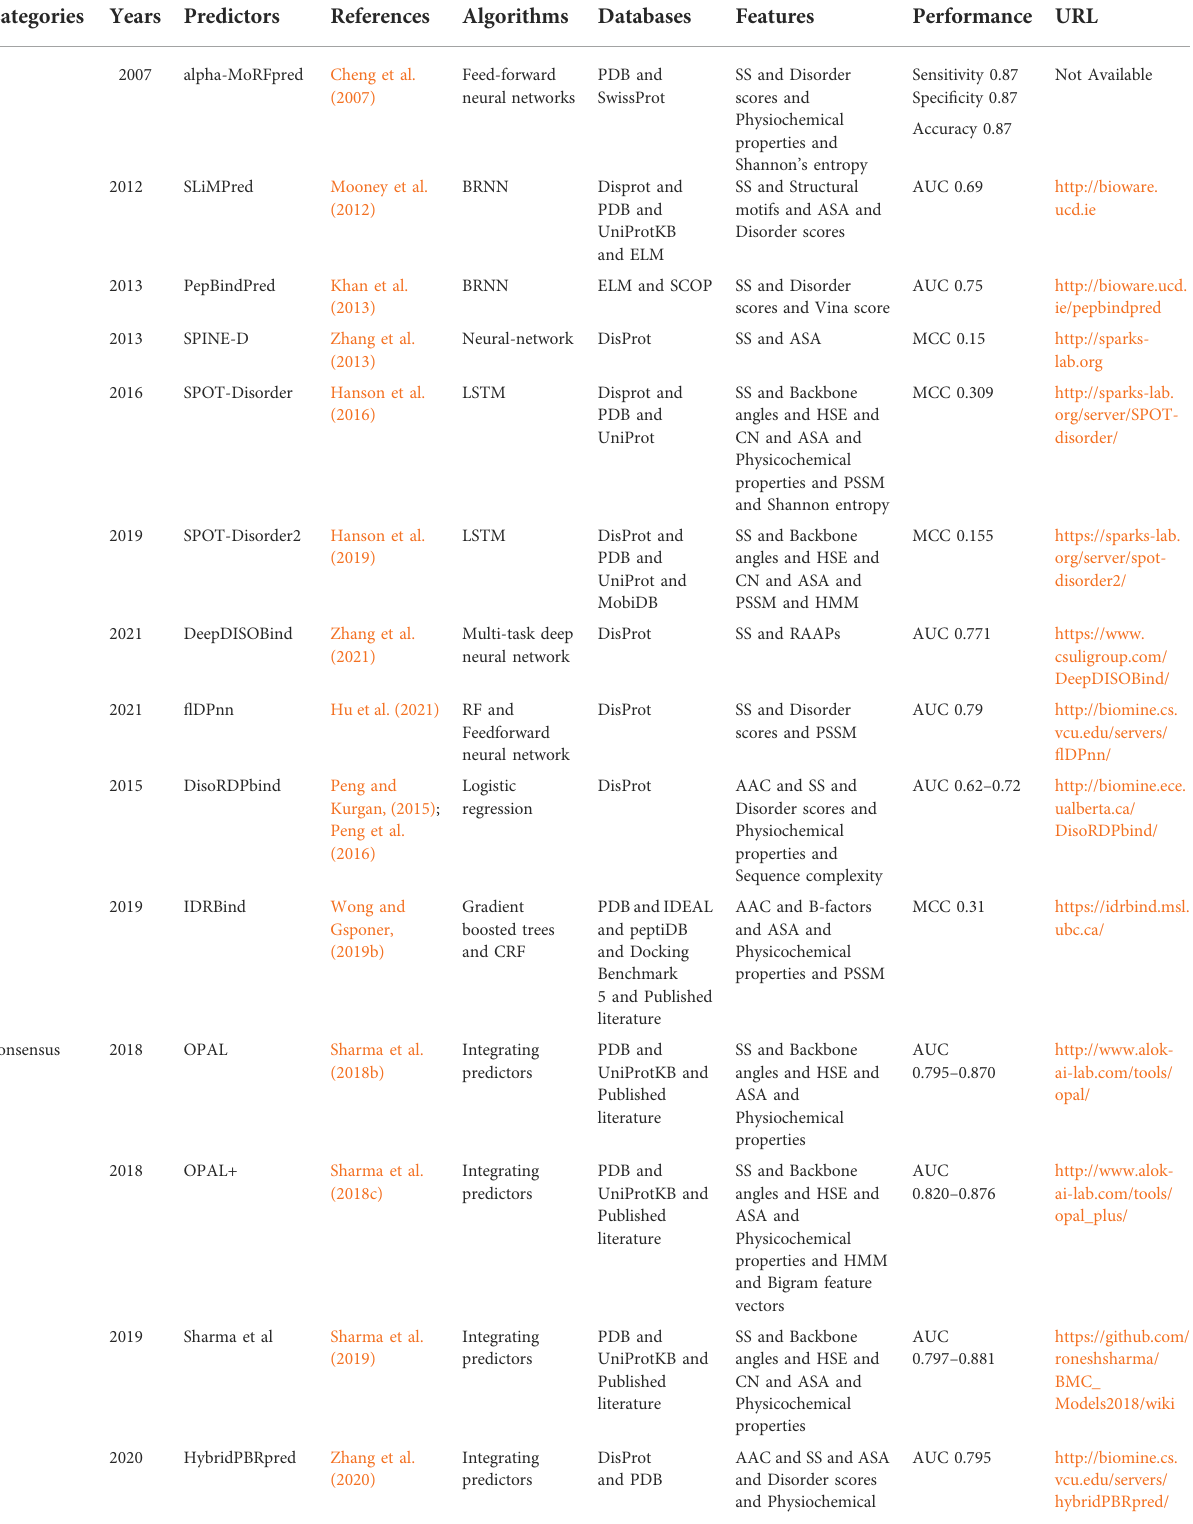
TABLE 2 ( Continued ) Summary of intrinsically disordered protein-protein interaction sites